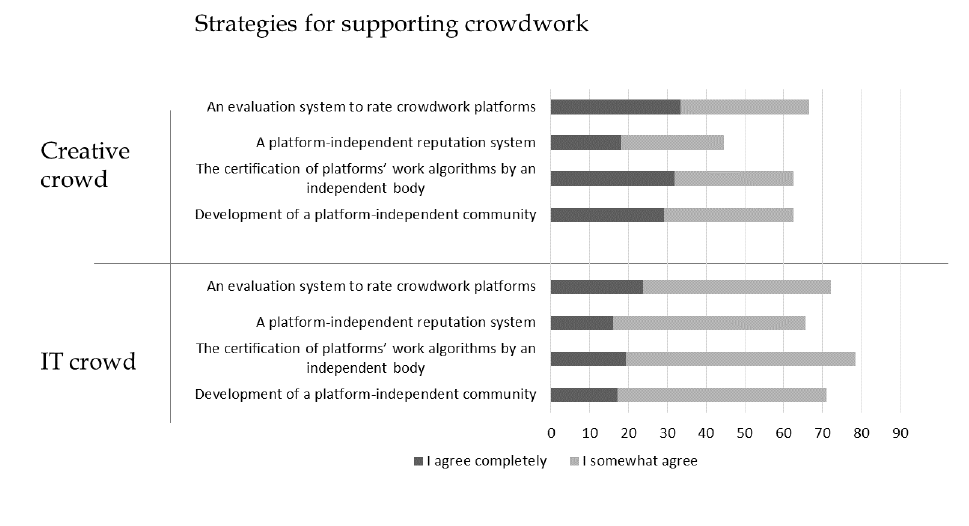
Figure 4: Strategies for supporting crowdwork (in per